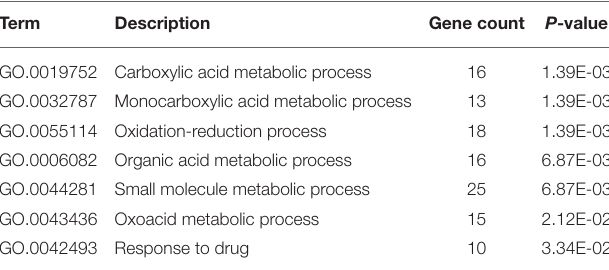
TABLE 2 | GO analysis of DEGs associated with NAFLD in the RRA analysis.